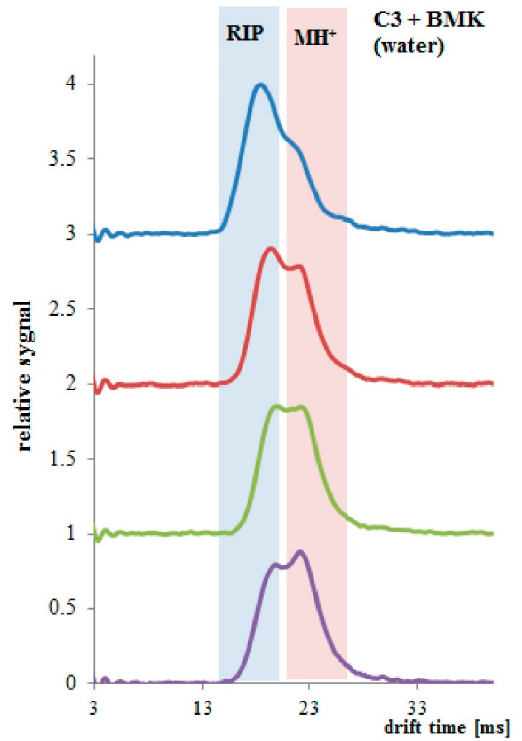
Figure 9. PP tubing coated three times with PSi, spectra collected every 1 min, total time 3 min. IMS analysis is characterized by both high sensitivity and the shortest time of analysis of 60 s. However, the application of IMS analysis for the detection of some drug precursors present in the sewage water system suffered from the easiness of sensor probe contamination and clogging. We have proposed a simple solution using as a probe microporous PP tubing coated with a thin PSi layer. Within 60 s of the experiment, the presence of BMK at a concentration equal to 4 ppm was easily detected. In most of the available studies, the analysis of aqueous solutions is carried out in flow systems. This necessitates the performance of specialized sample introduction systems. The method proposed by us solves the situation of collecting samples directly from the flowing sewage, which only contributes to the need to directly connect the sorption tube to the IMS detector. Collection of the sample and its introduction to the detector is performed with the use of a suction pump. Due to the simple structure of the system, it can be used in the construction of modules placed in the sewage system, allowing for continuous monitoring of the discharged sewage waste. 4. Patents Patent application for this effective capillary PP/PSi probe sensor was filled. Author Contributions: Conceptualization, M.M. and W.F.; Methodology, M.S. and J.W.; Investigation, M.W.-S. and U.K.; Writing—Original Draft Preparation, W.F.; Writing—Review and Editing, J.W. and M.W.-S.; Visualization, J.W. and M.W.-S.; Supervision, M.M.; Funding Acquisition, M.M. All authors have read and agreed to the published version of the manuscript. Funding: This research received no external funding